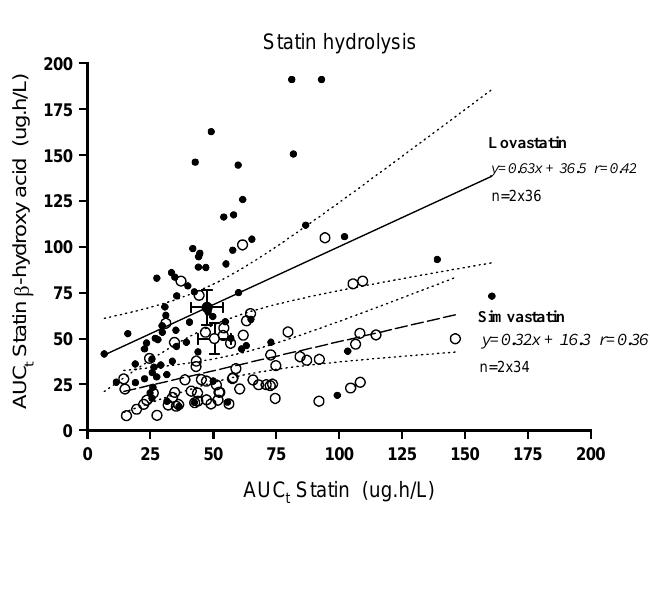
FIGURE 2. AUC t plots statin vs. statin β -hydroxy acid of lovastatin (solid dots, line) and simvastatin (open dots, interrupted line) with 95% CI intervals (dotted